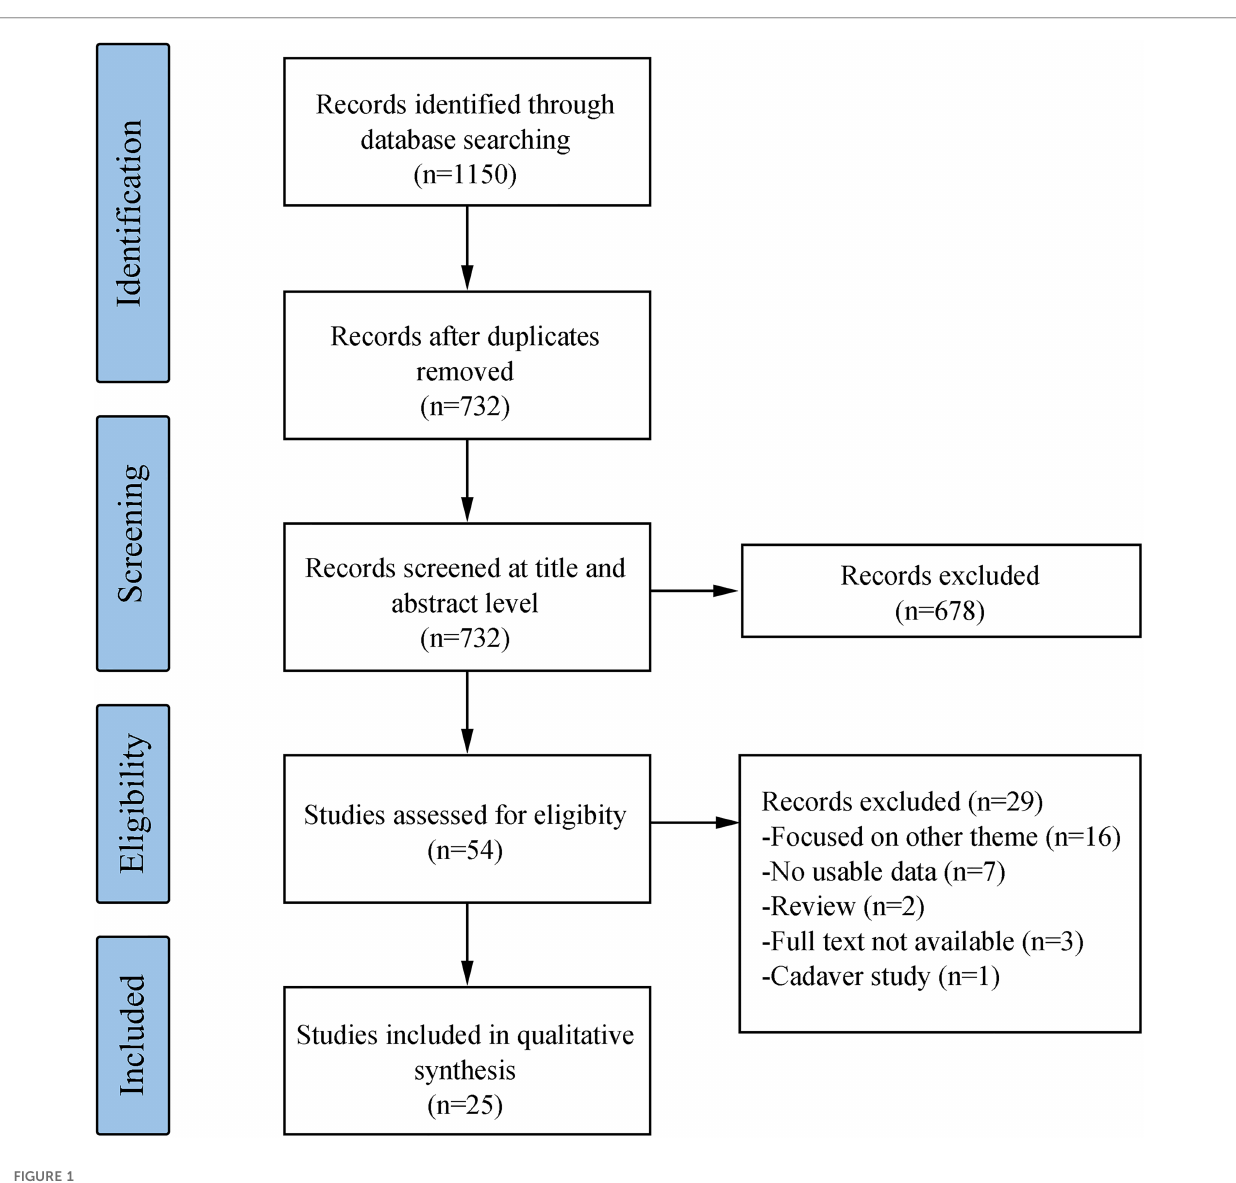
FIGURE 1 Flowchart of the search strategy and included